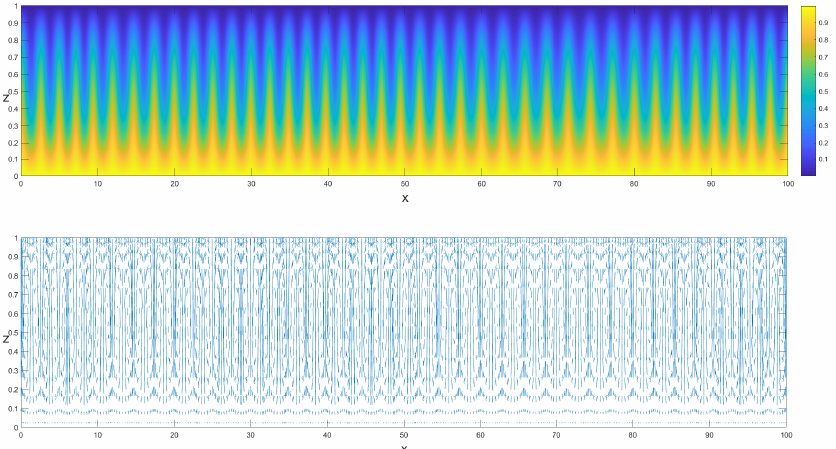
Figure 17. Isotherms and velocity field of a numerical solution obtained with alternating Schwarz domain decomposition; R = 1300, Γ = 100, np = 35, mp = 2, N × M = 16 × 10.